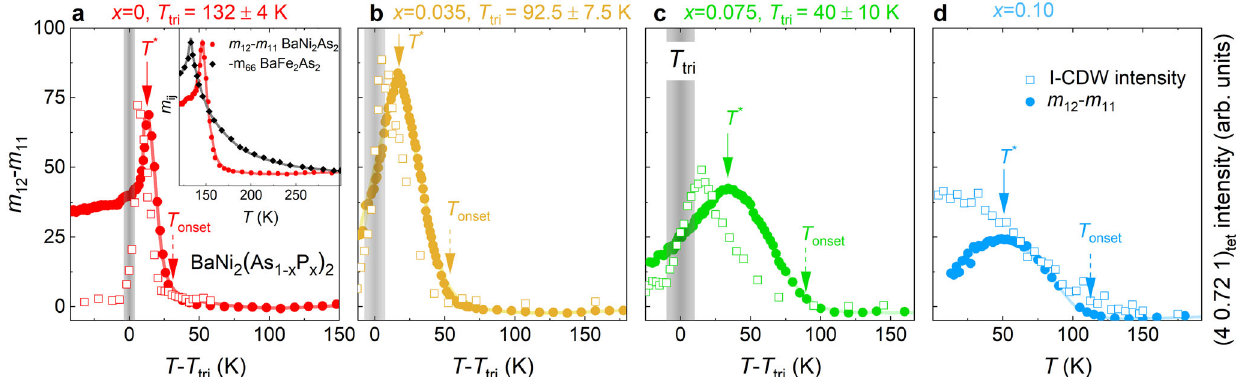
Fig. 3 Evolution of m 12 − m 11 with P-concentration in BaNi 2 (As 1 − x P x ) 2 . a – d B 1g symmetry-resolved m 12 − m 11 elastoresistance coef fi cient ( fi lled circles, left axis) together with the integrated intensity of the I-CDW satellite at Q I-CDW = (4 0.72 1) tet (empty squares, right axis, reproduced from ref. 27 ), for different x values as indicated. Both quantities are shown upon cooling, except for the x = 0.10 X-ray diffraction (XRD) data, and plotted as a function of T − T tri , where the triclinic transition temperature is measured upon cooling. No triclinic phase is observed at x = 0.10 and thus the data are as a function of T in d . The gray area represents the width of the triclinic transition as determined from the elastoresistance samples (see Supplementary Note 5). Note that elastoresistance and XRD measurements are performed on different samples that share similar triclinic transition temperatures, except for x = 0.075 where the XRD sample has a slightly lower P-content and accordingly higher T tri ≈ 55K. The arrows indicate the onset temperature of m 12 − m 11 , T onset , and the temperature of the elastoresistance maximum, T * . In the inset of a the B 2 g -symmetric − m 66 elastoresistance coef fi cient of BaFe 2 As 2 from ref. 42 (black diamonds, vertically scaled) is compared to the m 12 − m 11 coef fi cient of BaNi 2 As 2 . Lines are guides to the eye.